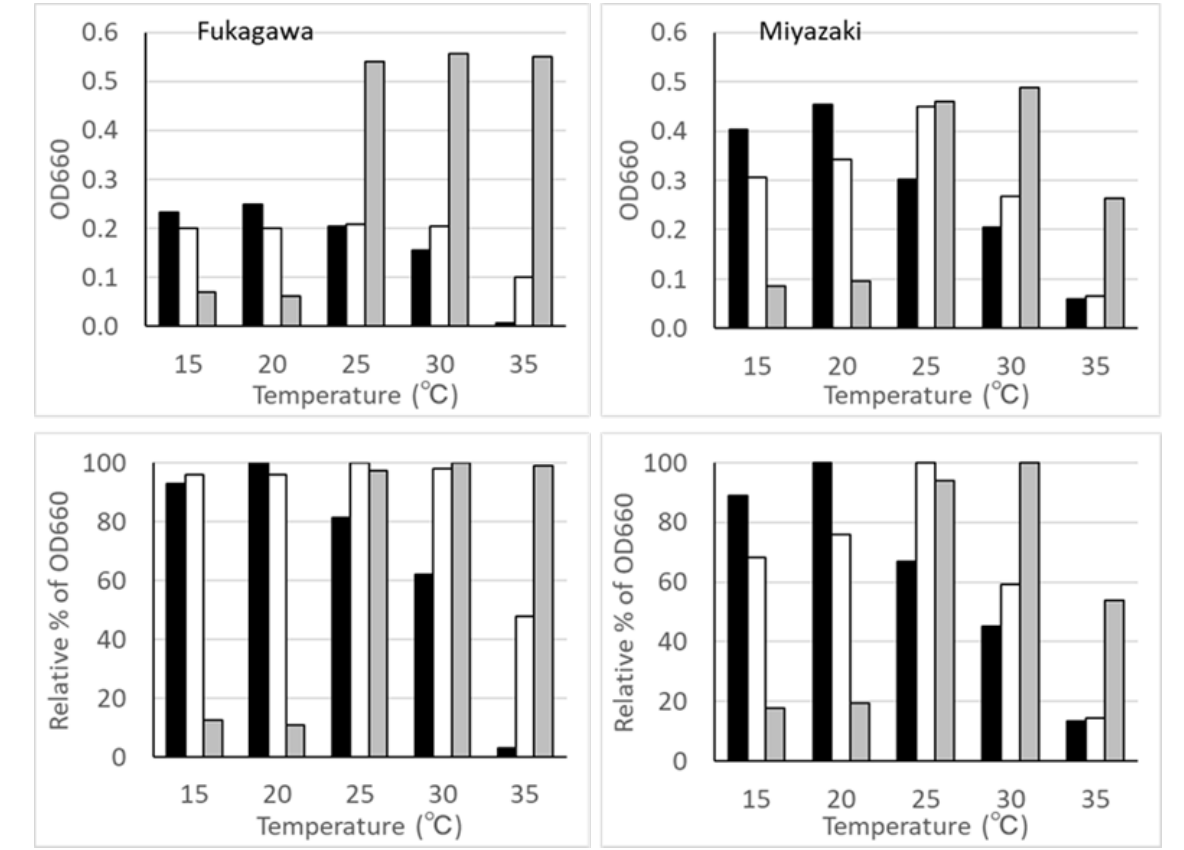
Figure 2. Effects of temperature on growth of Bradyrhizobium spp. strains in liquid culture. Upper: OD 660 at 5 days, lower: relative percentage of OD 660 to maximum for each strain. Fukagawa strains: B. japonicum Hh 16-9 (Bj11-1) ( ■ ), B. japonicum Hh 16-25 (Bj11-2) ( □), and B. elkanii Hk 16-7 (BeL7) ( ); Miyazaki strains: B. japonicum Kh 16-43 (Bj10J-2) ( ■ ), B. japonicum Kh 16-64 (Bj10J- 4) (□), and B. elkanii Kh 16-7 (BeL7) ( ).